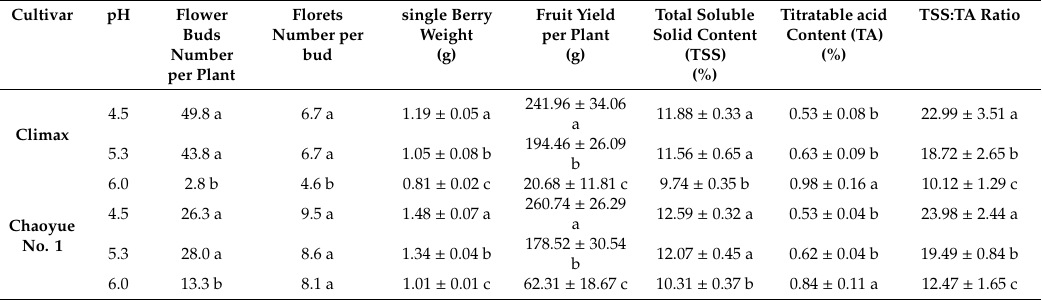
Table 4. E ff ect of di ff erent pH treatments on the fruit yield and quality of two blueberries. Cultivar